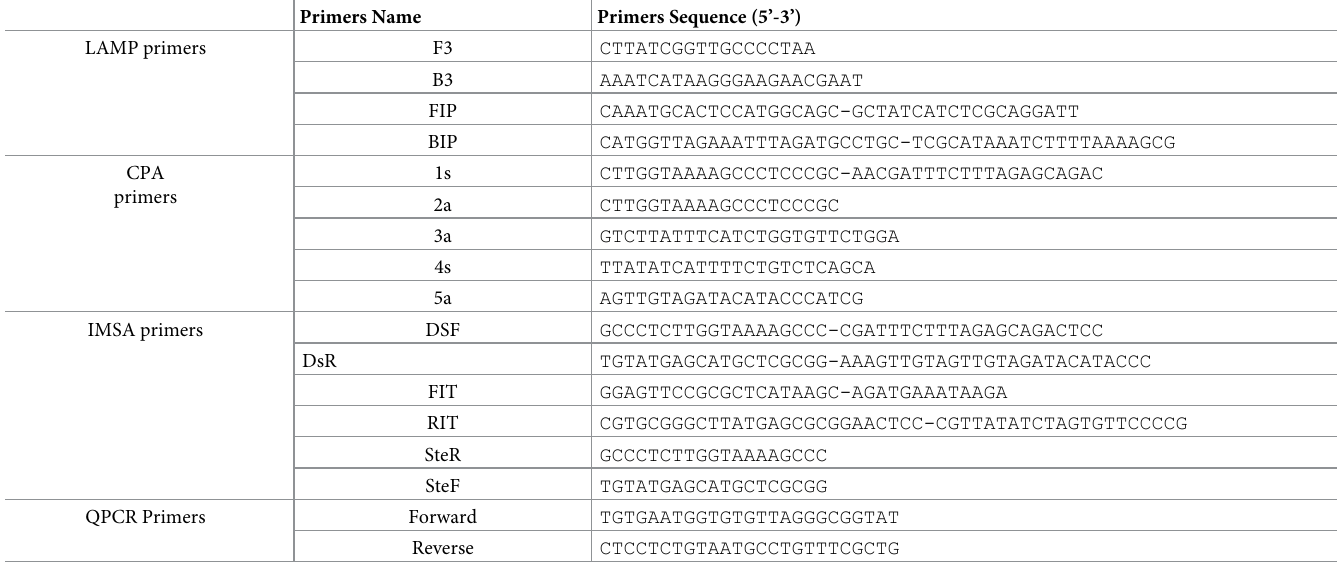
Table 2. Primers for LAMP, CPA, IMSA and Q-PCR